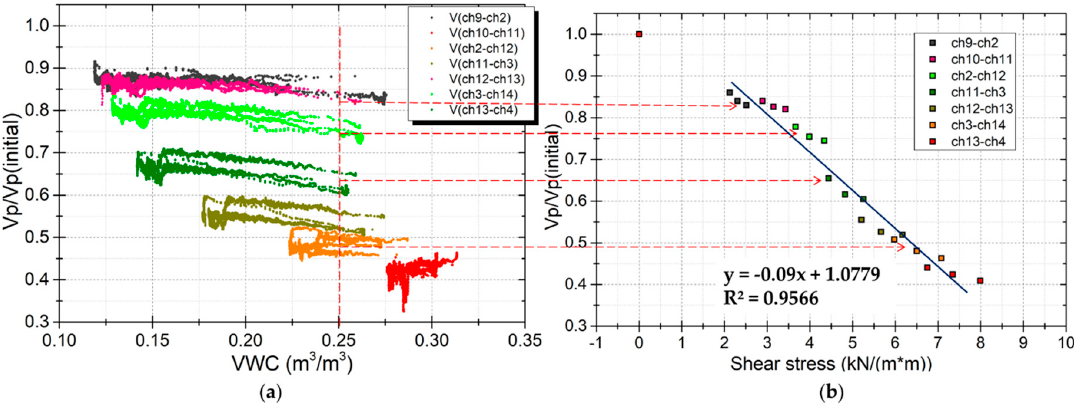
Figure 15. Response of wave velocities at different levels of shear stress during drain events. ( a ) Wave velocity ratio against shear stress during the drain event. ( b ) Wave velocity ratio response with shear stress at the same 0.25 m 3 /m 3 of VWC.